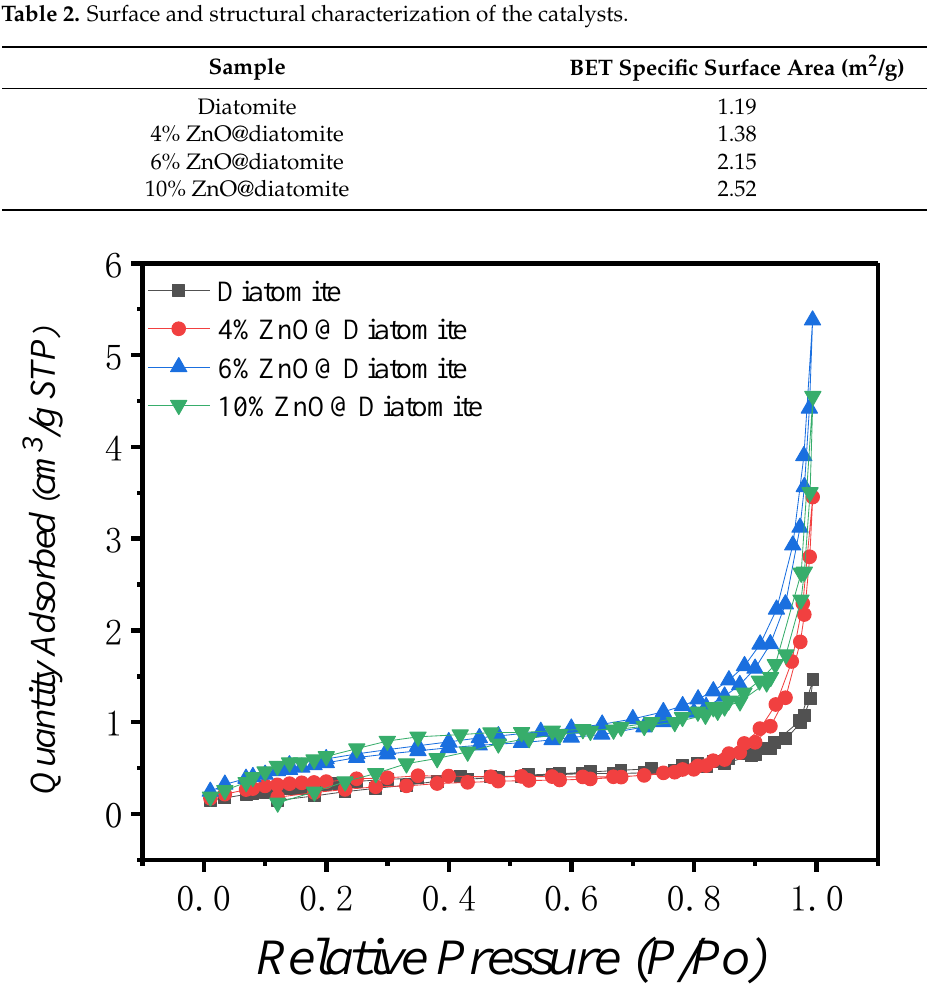
Table 2. Surface and structural characterization of the catalysts.